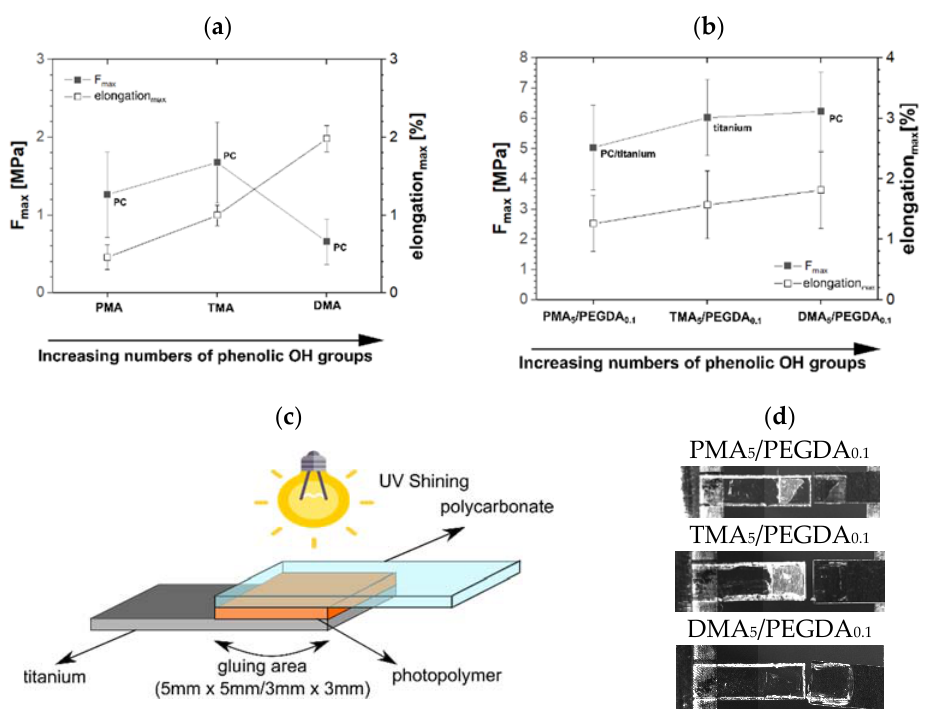
Figure 6. Tensile shear tests of photopolymers XMA ( a ) all adhesion fractures occurred to the PC surface) and photopolymers with crosslinker XMA 5 /PEGDA 0.1 ( b ), Sample set up of tensile shear test ( c ) and destroyed samples ( d ).